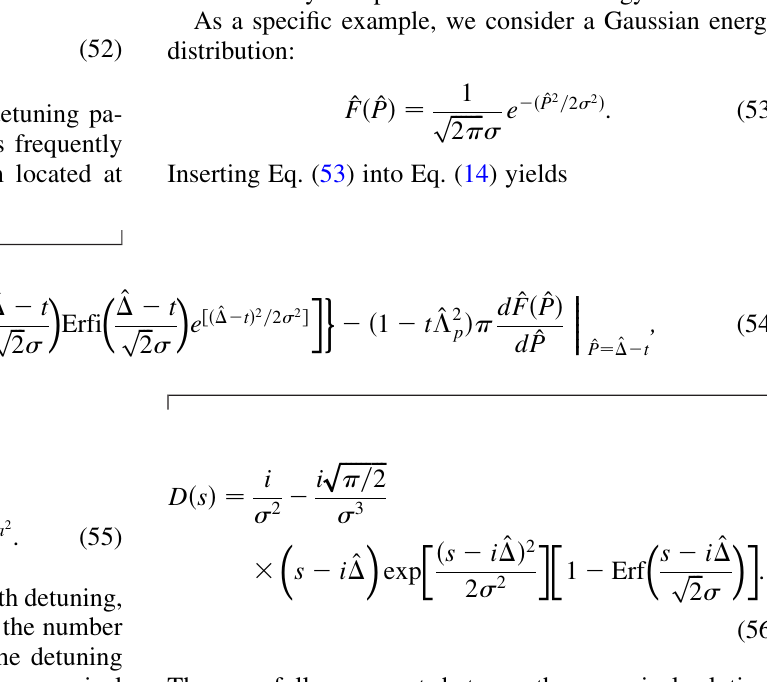
^ P ¼ p ¼ 0 . The general dependence of high-frequency 1 cutoff on the energy spread and space-charge parameter has the form ^ (cid:3) (cid:11) ¼ ð a(cid:7) 2 þ ^ (cid:2) 2 p Þ (cid:3) 1 , with the coefficient a determined by the specific form of the energy distribution.